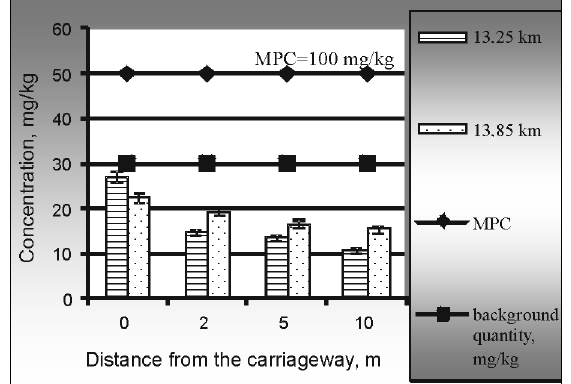
Fig. 6. Chromium concentration in the roadside soil of the gravel road Jusevičiai – Būdvietis –